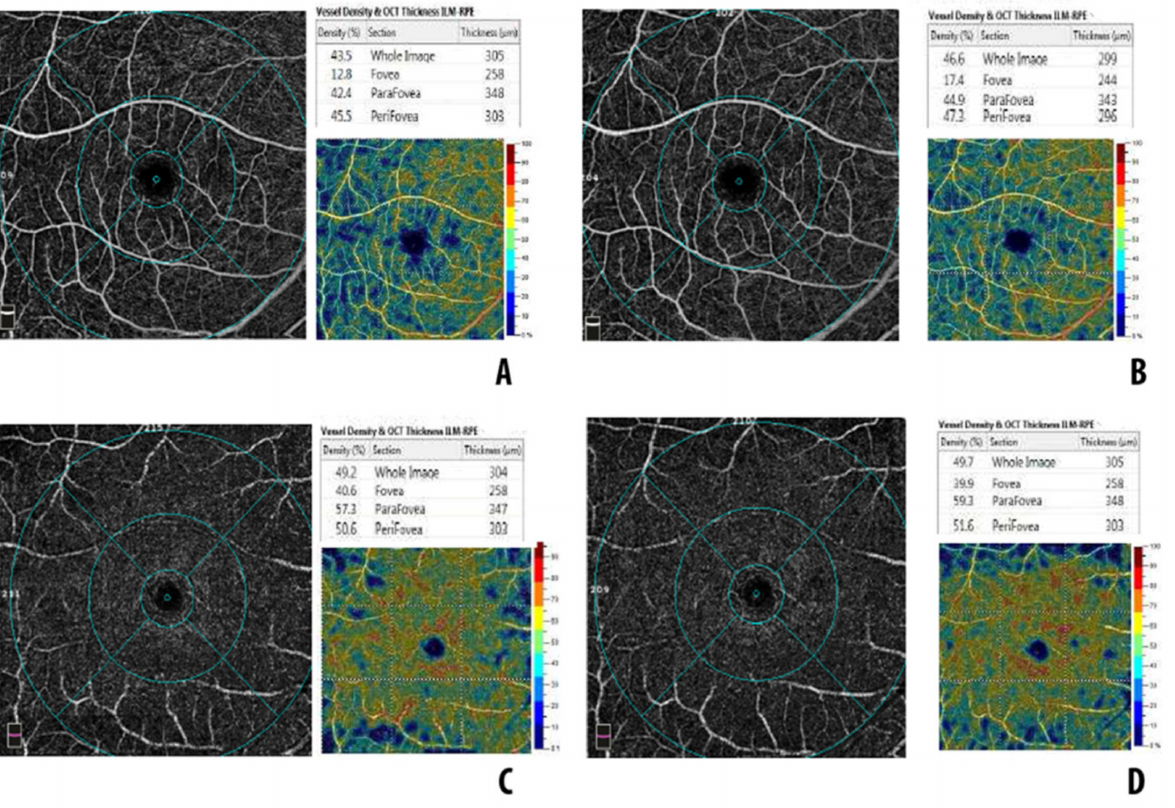
Figure 1. OCTA imaging in a case of macula-on retinal detachment: ( A ) baseline superficial capillary plexus; ( B ) superficial capillary plexus at 6 months postoperatively; ( C ) baseline deep capillary plexus; ( D ) deep capillary plexus at 6 months